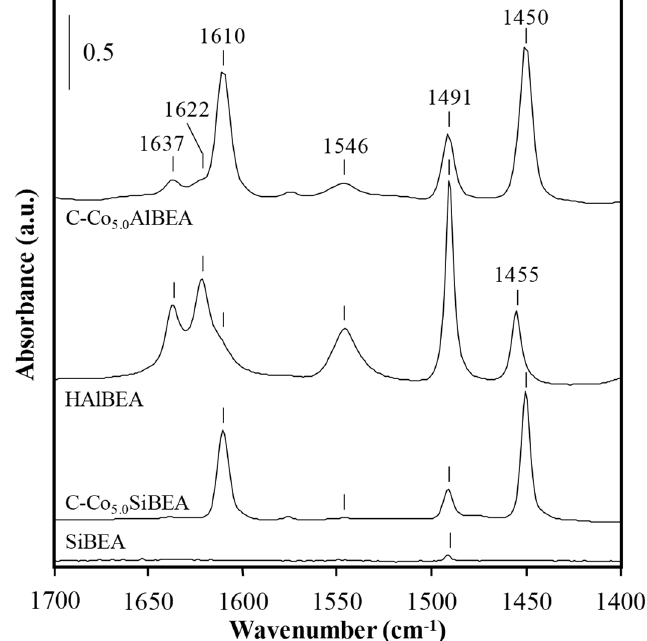
Figure 7. FTIR spectra of AlBEA, SiBEA, Co 5.0 AlBEA and Co 5.0 SiBEA after desorption of pyridine at 150 °C showing no Brønsted and Lewis acidic sites in siliceous SiBEA.